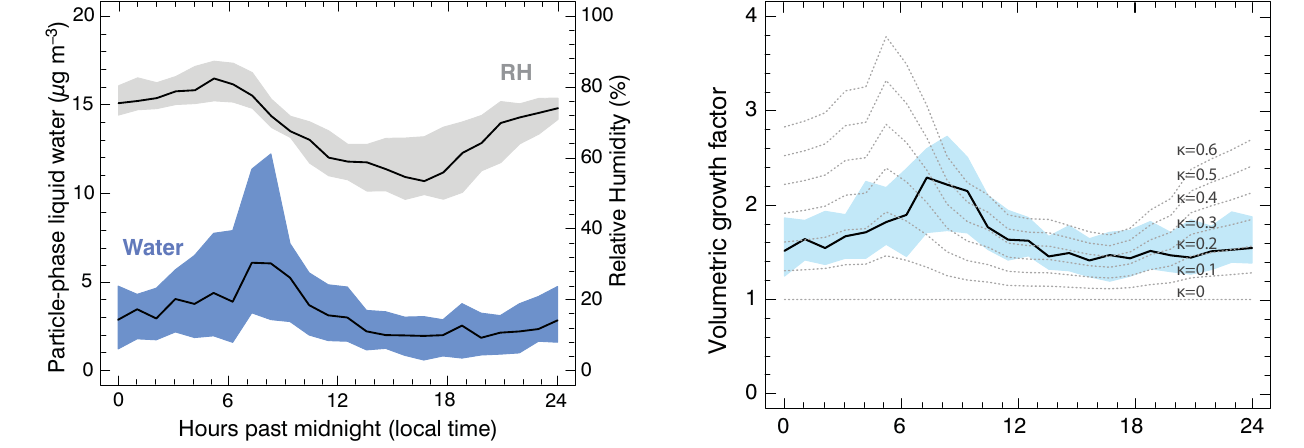
Figure 6. Campaign-averaged diel profiles of total particle-phase liquid water mass concentrations and RH binned into hourly inter- vals. The central lines indicate the median and the shaded regions indicate the interquartile range.